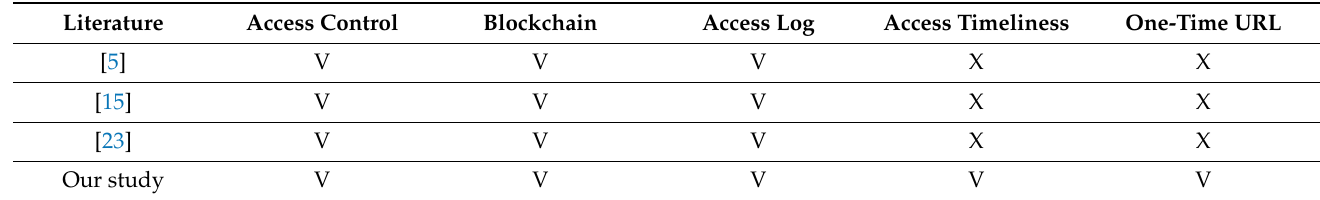
Table 3. Comprehensive